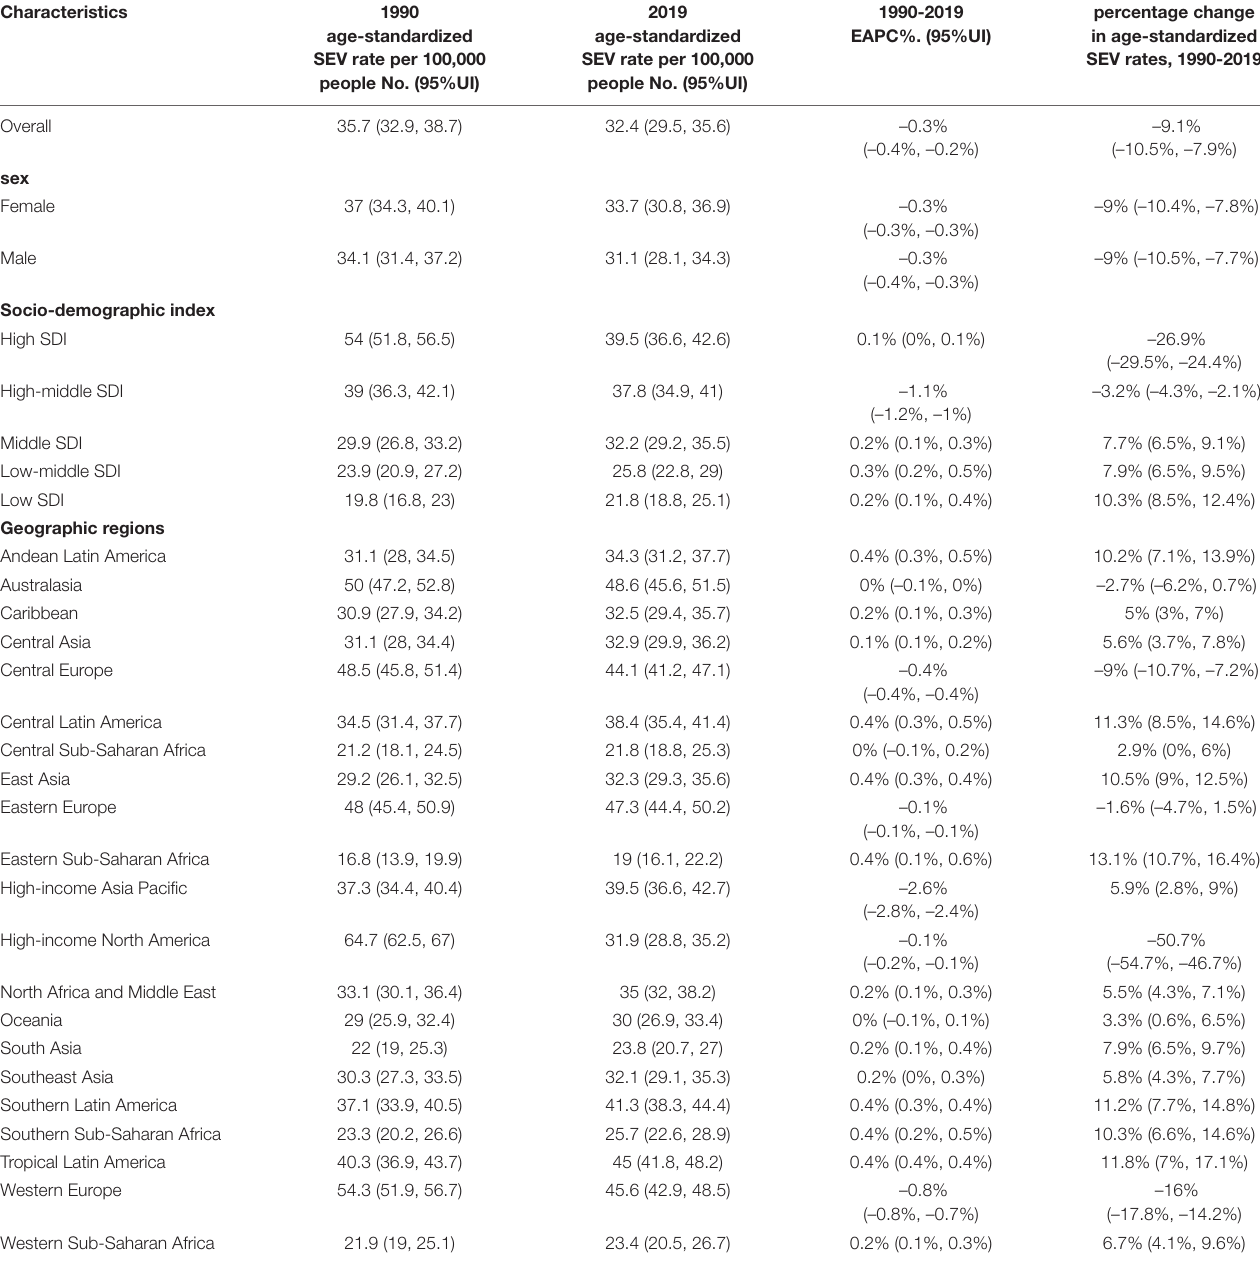
TABLE 1 | Trends of ASR SEV attributable to high LDL-C in 1990 and 2019.